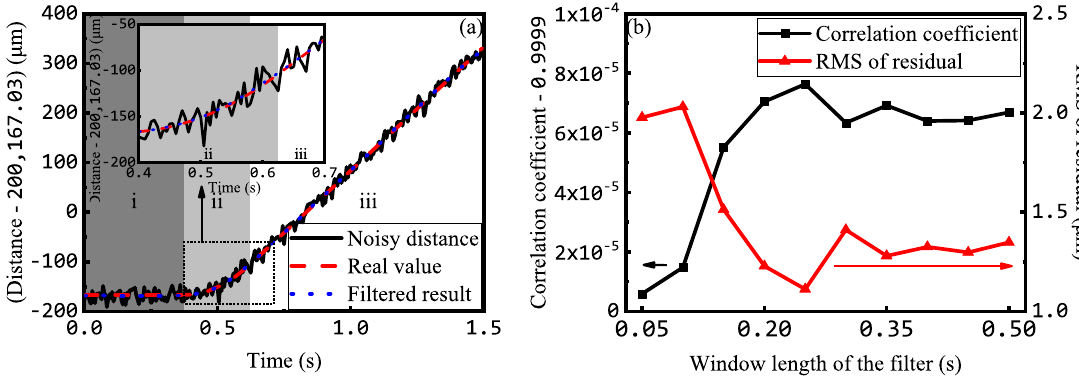
Figure 3. Simulated distance signal generated by Table 1. ( a ) Simulated distance in time-domain. Black line: noisy simulated distance, red dashed line: real value; blue dotted line: filtered result. State i: stationary; State ii: uniformly-accelerated motion; State iii: uniform motion. ( b ) Correlation coefficient (black line) and RMS of residual (red line) between real value and filtered result. Table 1. Simulated distance signal states of motion, corresponding to Figure